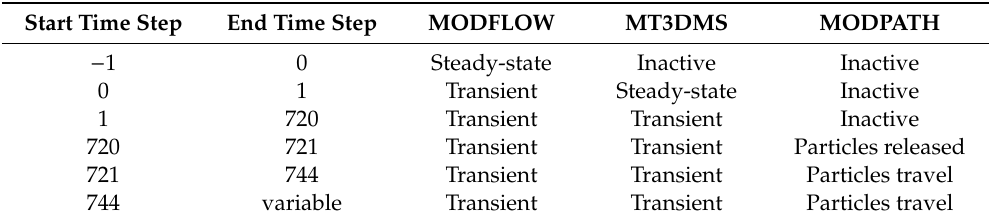
Table 2. The changing status and activity of the MODFLOW, MT3DMS, and MODPATH software through a simulation’s time